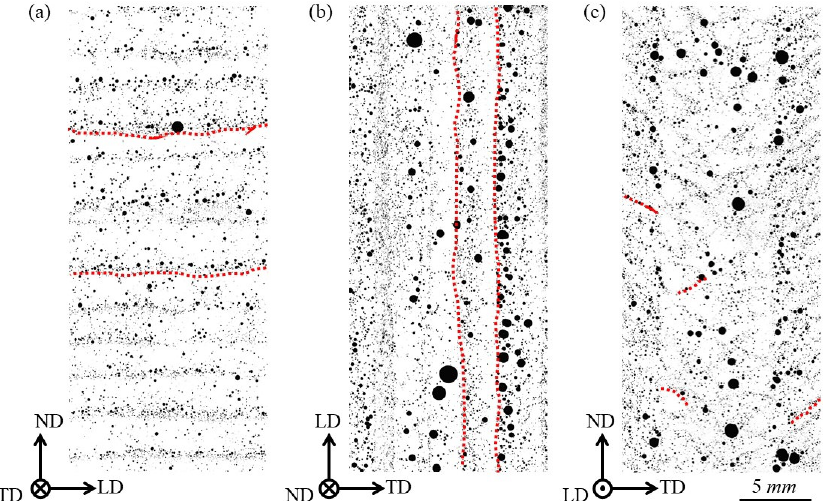
Figure 8. Porosity in WAAM-fabricated AA2319 in three orthogonal cross-sections ( a – c ). Some inter-layer boundaries are exemplarily highlighted in red.